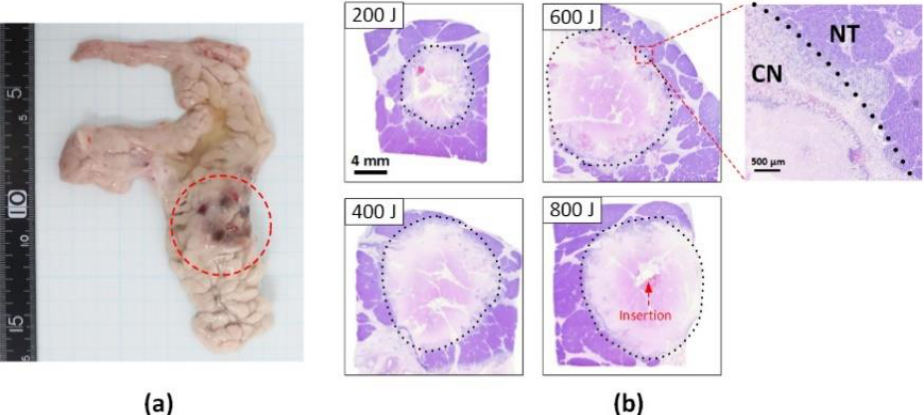
Figure 3. Assessments of thermal ablation in in vivo pancreatic tissue after 5 W LA at various energy levels: ( a ) gross pathology image after 400 J delivery (red circle = ablated area) and ( b ) transverse histological images acquired from tissue treated at various energy levels (CN = coagulation necrosis and NT = native tissue).